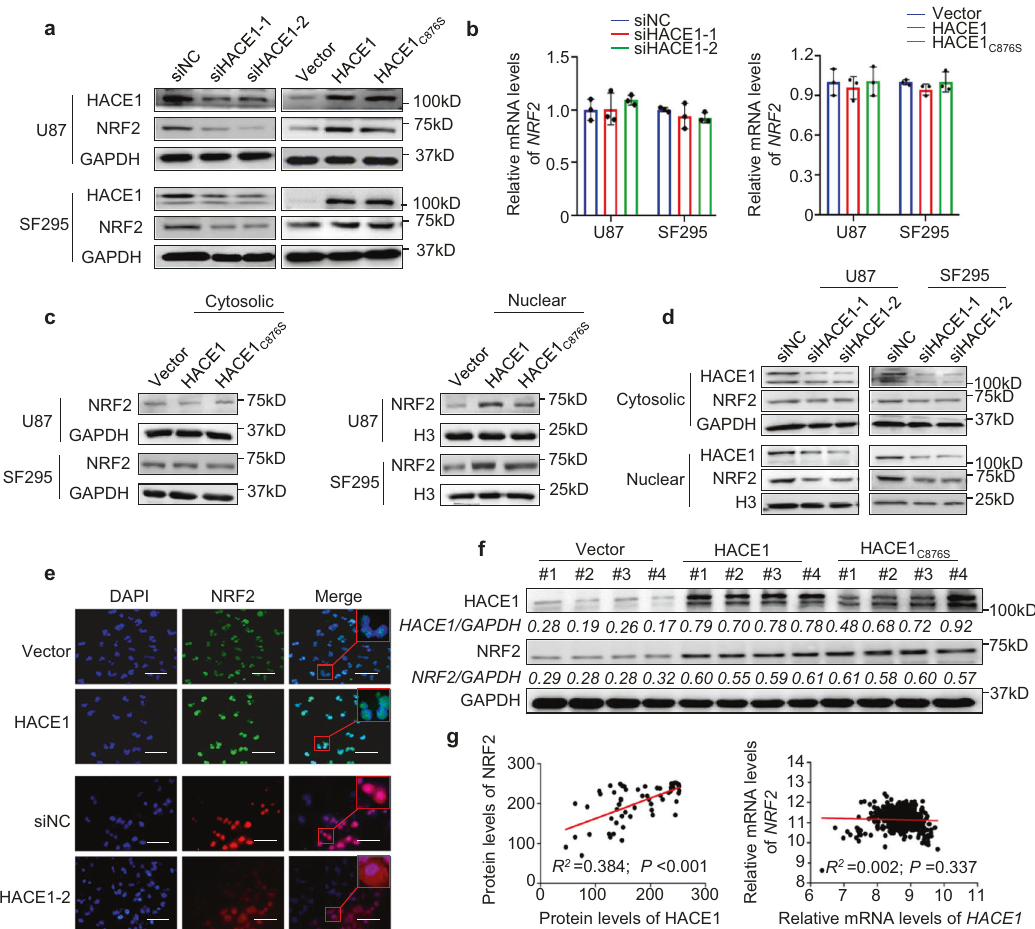
Fig. 3 HACE1 post-transcriptionally activates NRF2. a , b NRF2 expression was analyzed in HACE1 knockdown- or HACE1/HACE1 C876S overexpression-SF295 and U87 cells, and control cells by western blot and qRT-PCR assays. GAPDH and 18S rRNA were used as the normalized controls, respectively. c , d Western blot analysis of NRF2 in the cytosolic and nuclear fractions of HACE1/HACE1 C876S overexpression- or HACE1 knockdown-SF295 and U87 cells, and control cells. GAPDH and Histone H3 were used for loading controls, respectively. e Immuno fl uorescence was carried out to determine the effect of overexpression and knockdown of HACE1 on NRF2 localization in SF295 cells. Red squares indicate the magni fi cations of the area. Scale bars, 20 μ m. f Western blot analysis of HACE1 and NRF2 in xenograft tumors. The densitometry ratio of HACE1 or NRF2 to GAPDH (loading control) was shown below the corresponding band. g The correlation between HACE1 and NRF2 mRNA levels was analyzed by using the TCGA RNA-Seq data set (left panel). The relationship between protein levels of HACE1 and NRF2 was determined by western blot analysis in a panel of gliomas (right